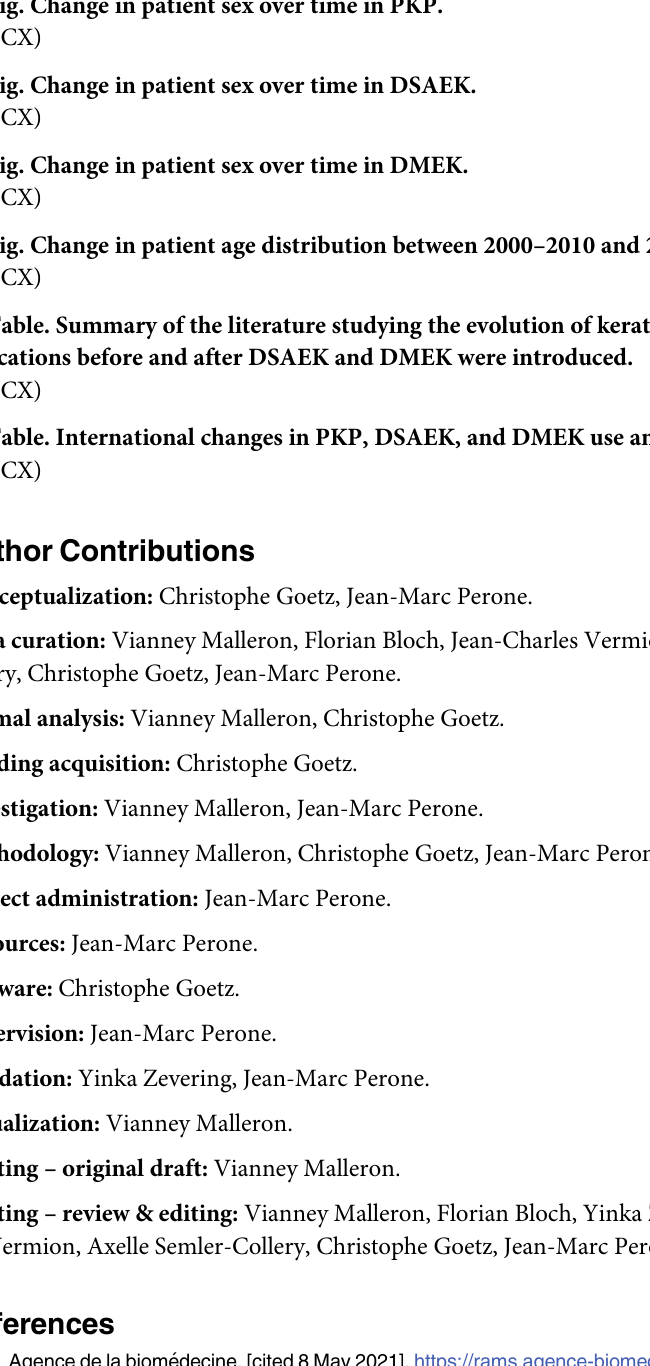
S1 Table. Summary of the literature studying the evolution of keratoplasty techniques and indications before and after DSAEK and DMEK were introduced. S2 Table. International changes in PKP, DSAEK, and DMEK use and